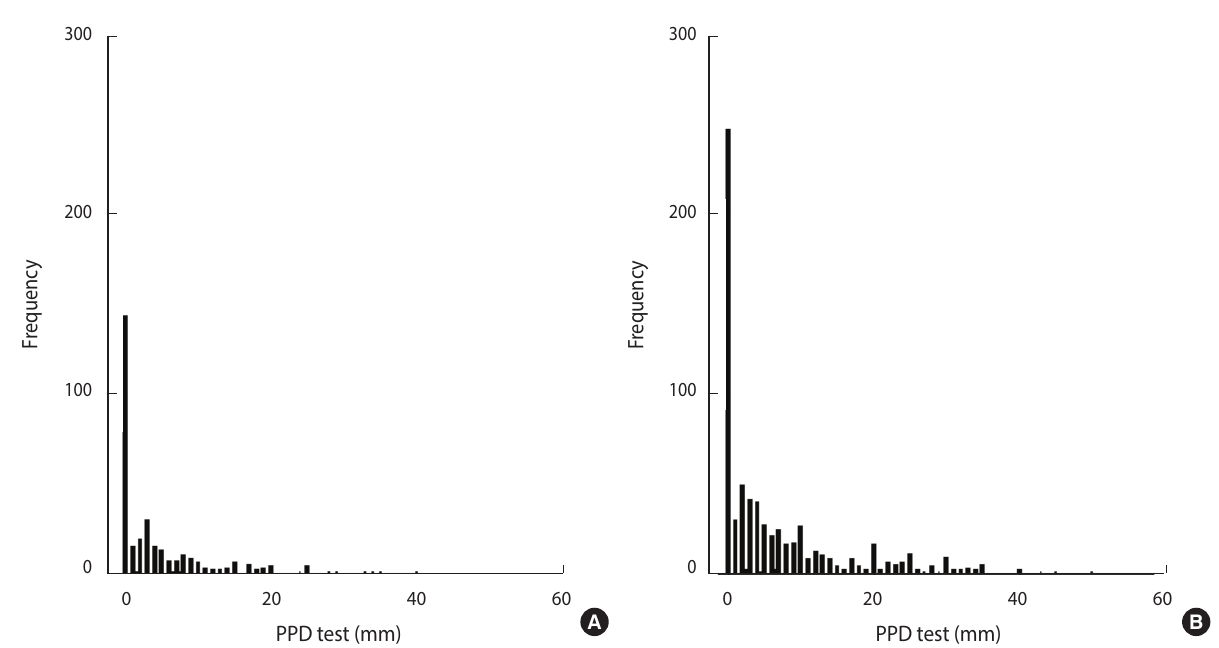
Figure 1. Distribution of TST test among low-risk HCWs (A) and TB laboratory staff (B). TST, tuberculin skin test; TB, tuberculosis; HCW, health care worker; PPD, purified protein derivative. Figure 1: distribution of TST test among TB laboratory staff and low HCWs. Figure 1: distribution of TST test among TB laboratory staff and low